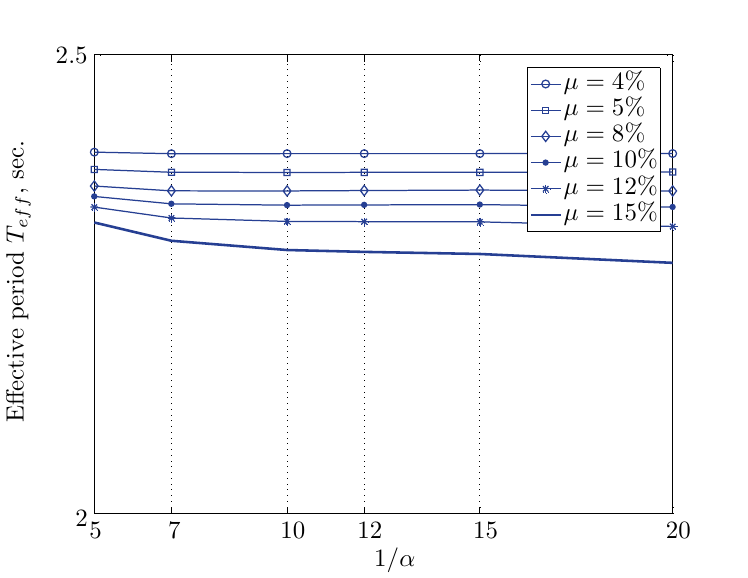
Figure 41. Effective period for various isolation system parameters